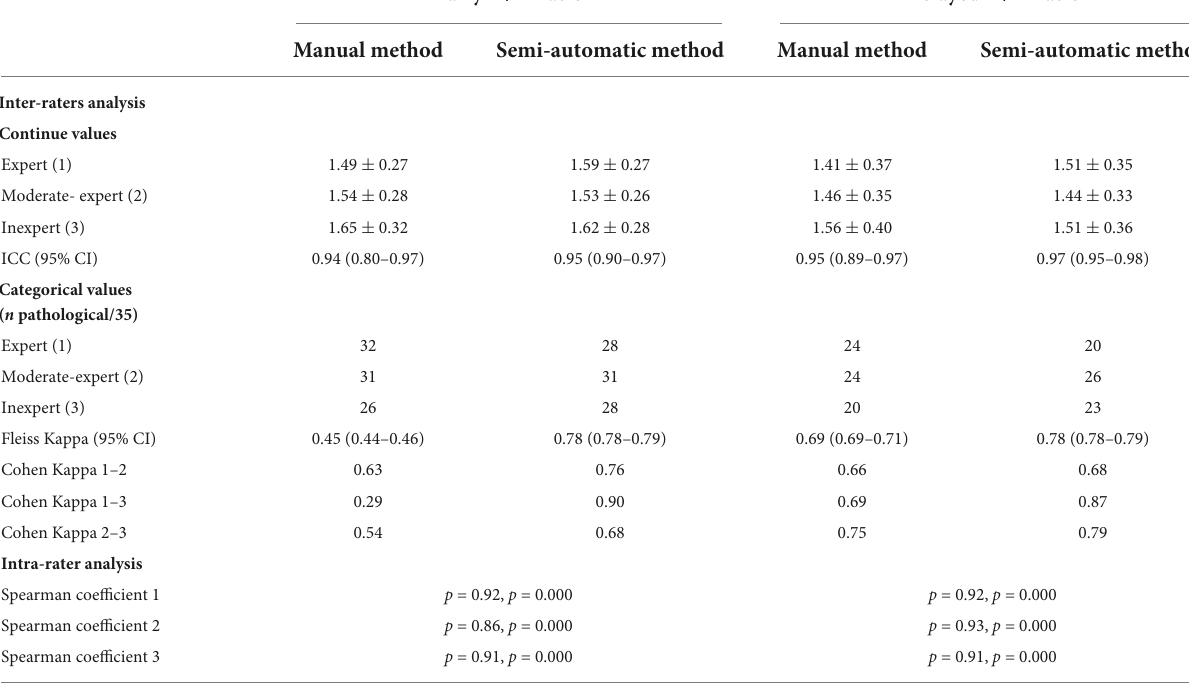
TABLE 1 Inter and intra-rater indices on 123 I-metaiodobenzylguanidine (MIBG)